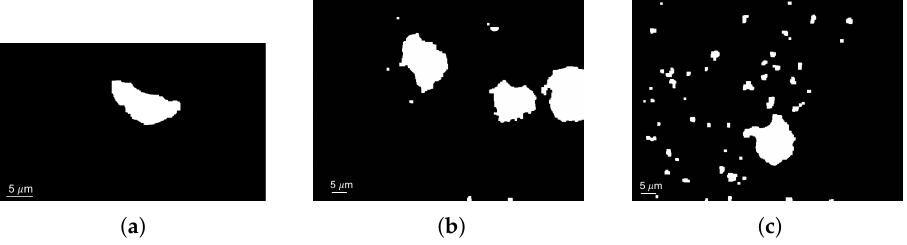
Figure 13. Result of applying floodfill algorithm on the eroded bright field images shown in Figure 12: